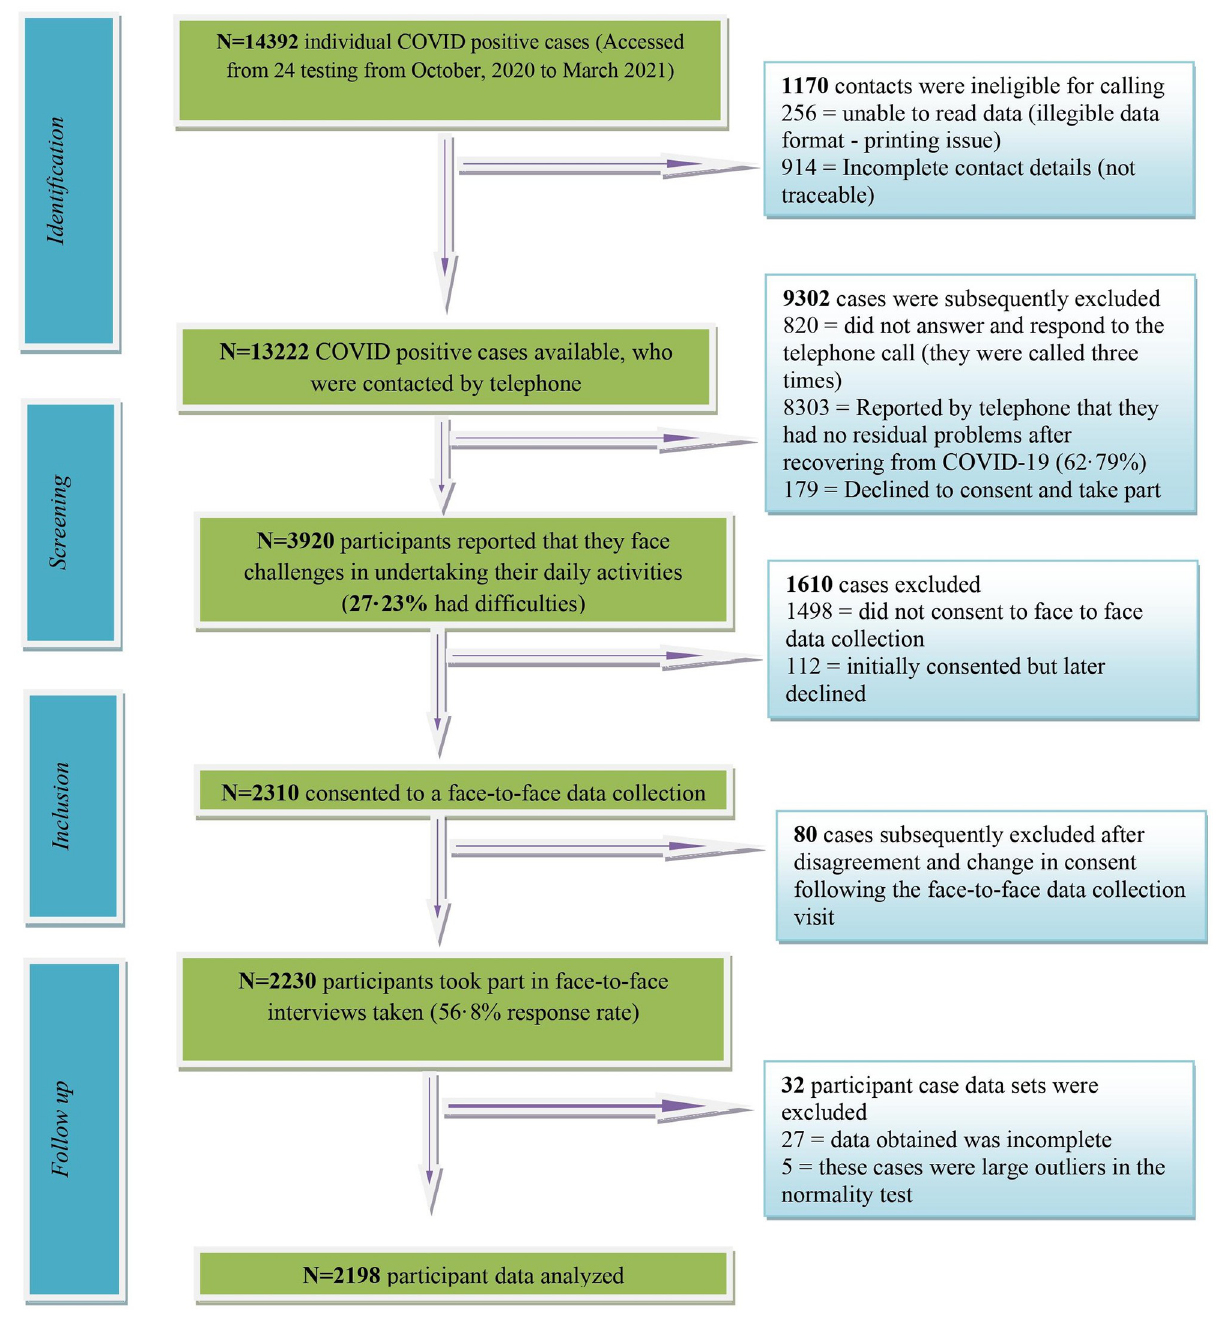
Fig 1. STROBE flow diagram of the